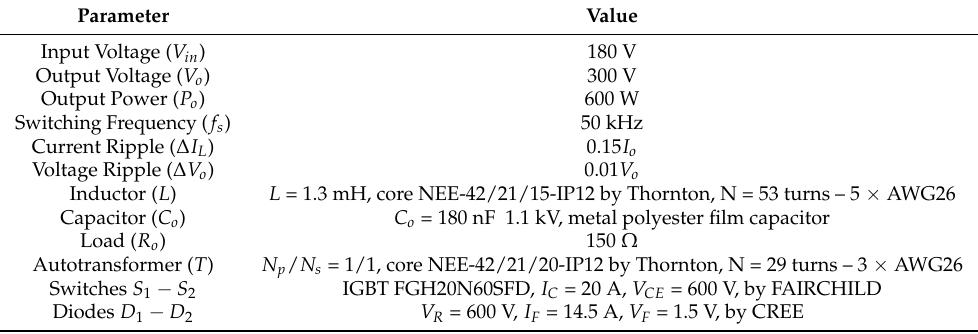
Table 1. Design specifications.